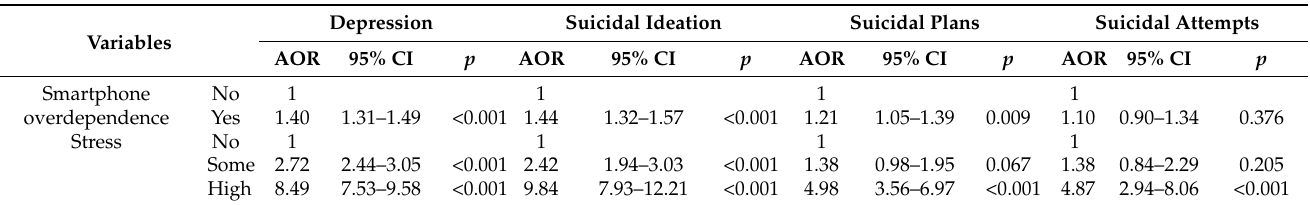
Table 3. Independent effects of smartphone overdependence and stress on depression, suicidal ideation, suicidal plans, and suicidal attempts.